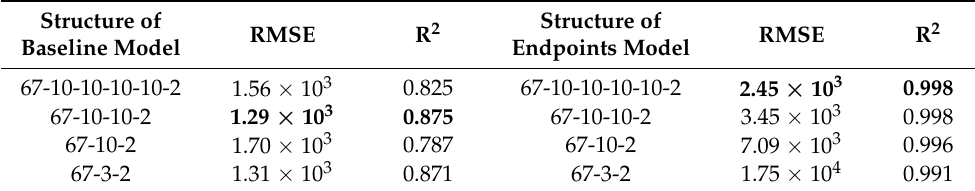
Table 3. The learning model structure and accuracy.